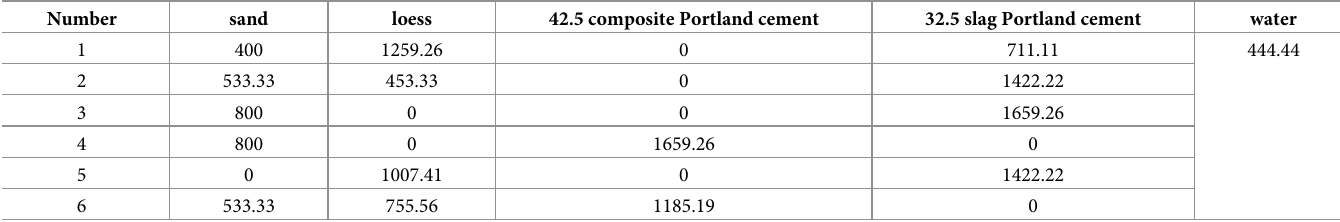
Table 1. Material ratio of different strength concrete blocks (kg/m 3